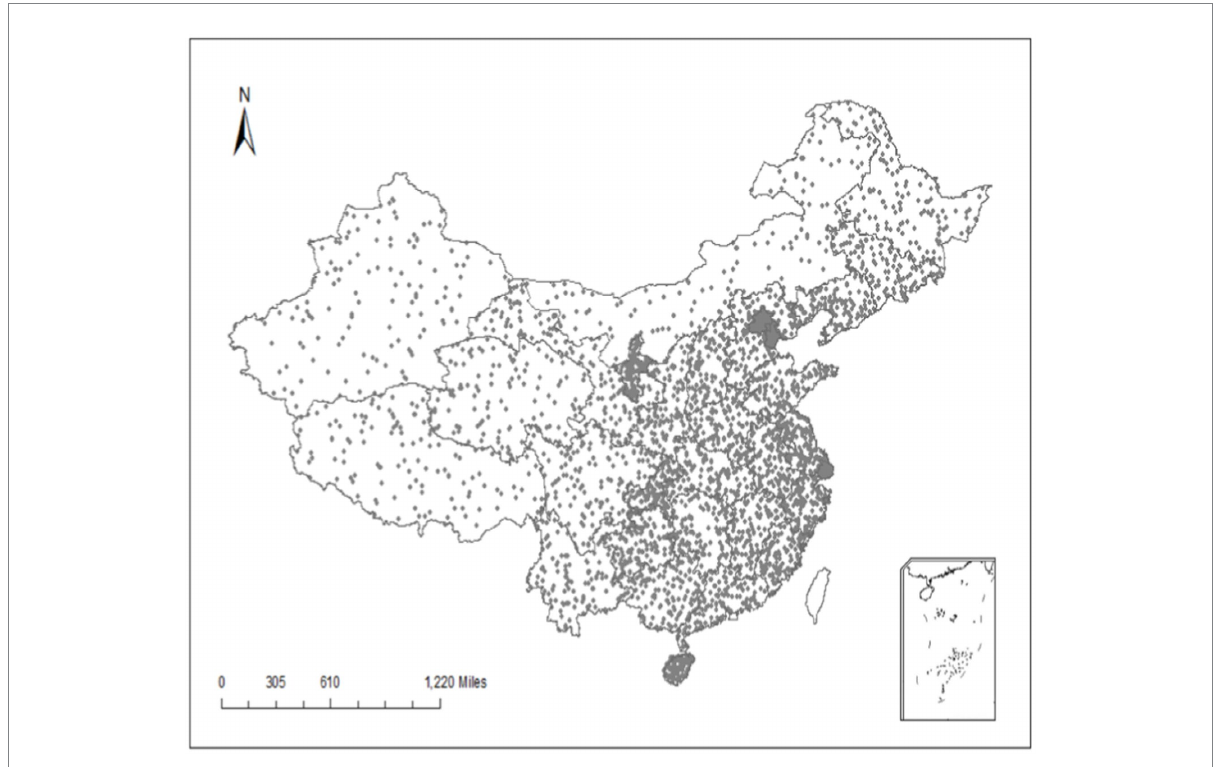
FIGURE 1 The geographical distribution of judicial reliance in